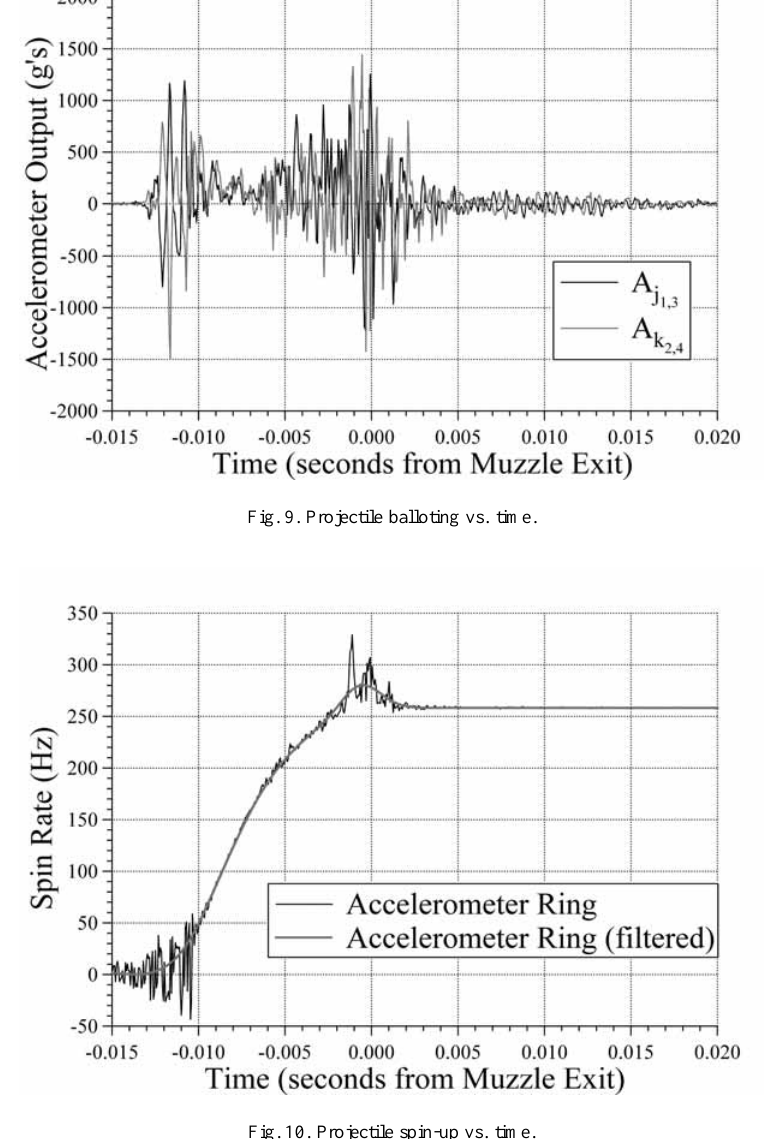
Fig. 10. Projectile spin-up vs.